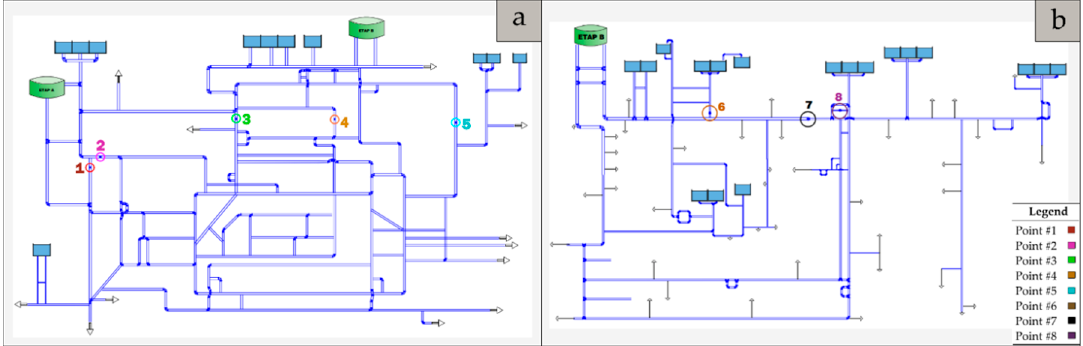
Figure 4. High-pressure water distribution system scheme from the VMS : ( a ) Points 1–5. ( b ) Points 6–8. Note. ETAPB is the connection point between schemes.